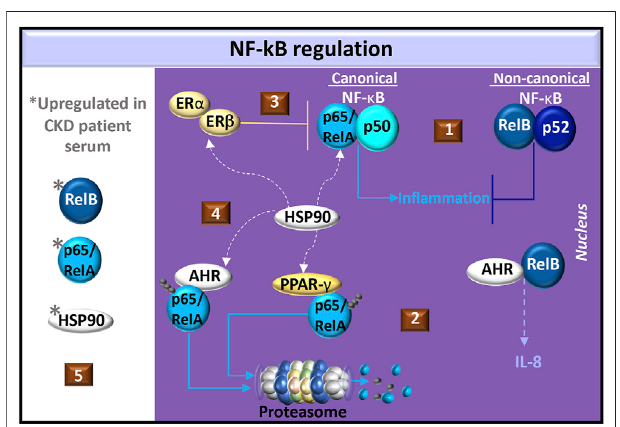
FIGURE5| RegulationofNF- κ BinCKD.(1)CommonNF- κ Bdimerpairs include p65/RelA and p50 in the canonical pathway and RelB and p52 in the non-canonical pathway. Non-canonical cell signals may antagonize canonical cell signals in fi broblasts. (2) AHR dimerizes with RelB in the production ofIL-8. AHRorPPAR- γ activation promotes ubiquitinationand degradation of p65/RelA. (3) Estrogen activates estrogen receptors (ER- α / β ) to produce the NF- κ B inhibitor, I κ B α , and promotes the recruitment of ER- β to p65 binding sites, which blocks p65 transcriptional activity. (4) Heat shock protein (HSP)- 90 is a chaperone shared by ER- α / β , PPAR- γ , AHR, and canonical NF- κ B. (5) Elevated levels of p65/RelA, RelB, and HSP90 are found in CKD patient